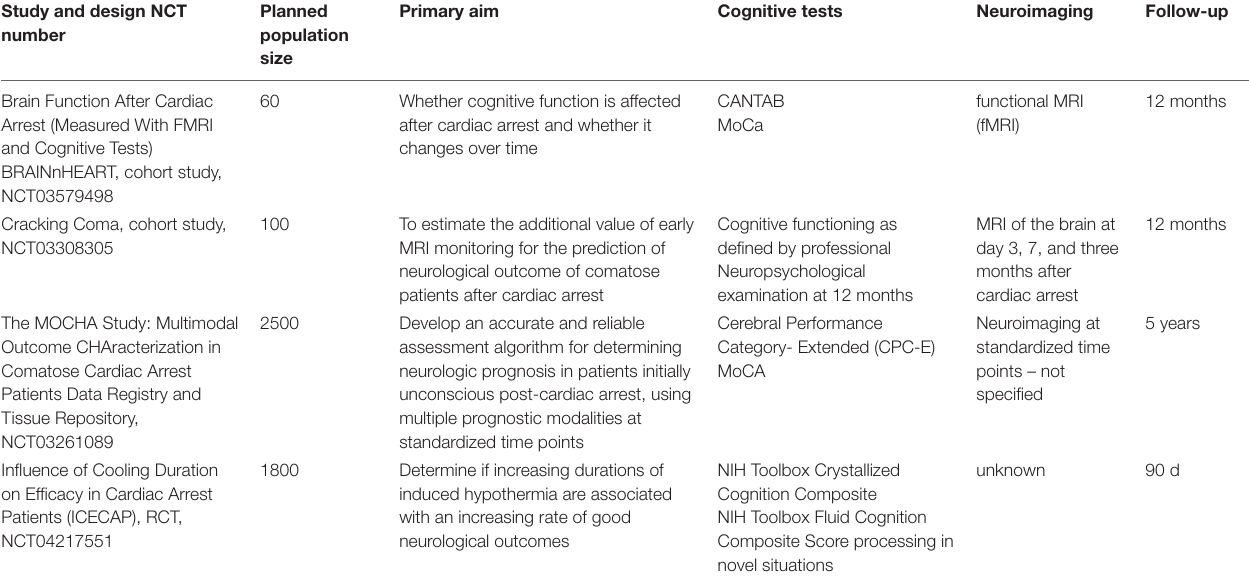
TABLE 2 | Ongoing trials registered at